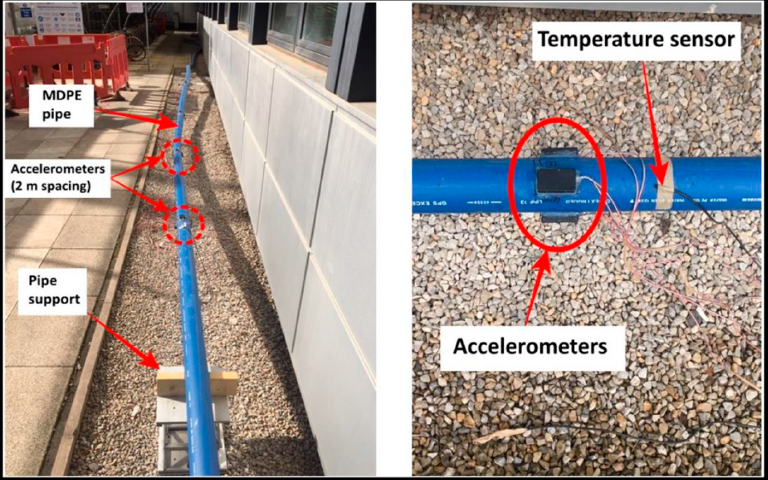
Figure 2. Experimental setup of the exposed MDPE pipe.